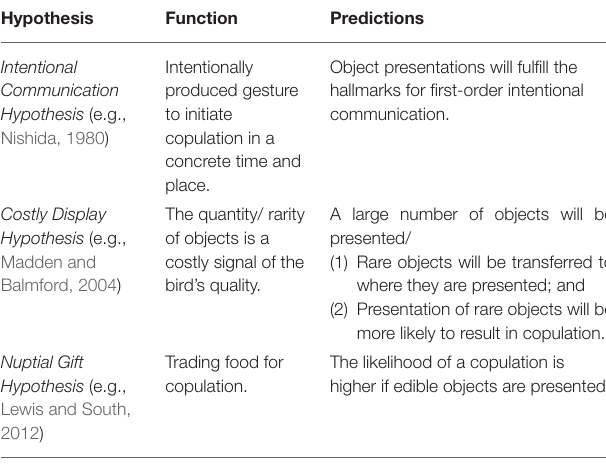
TABLE 3 | Hypotheses tested for the integration of objects in mating